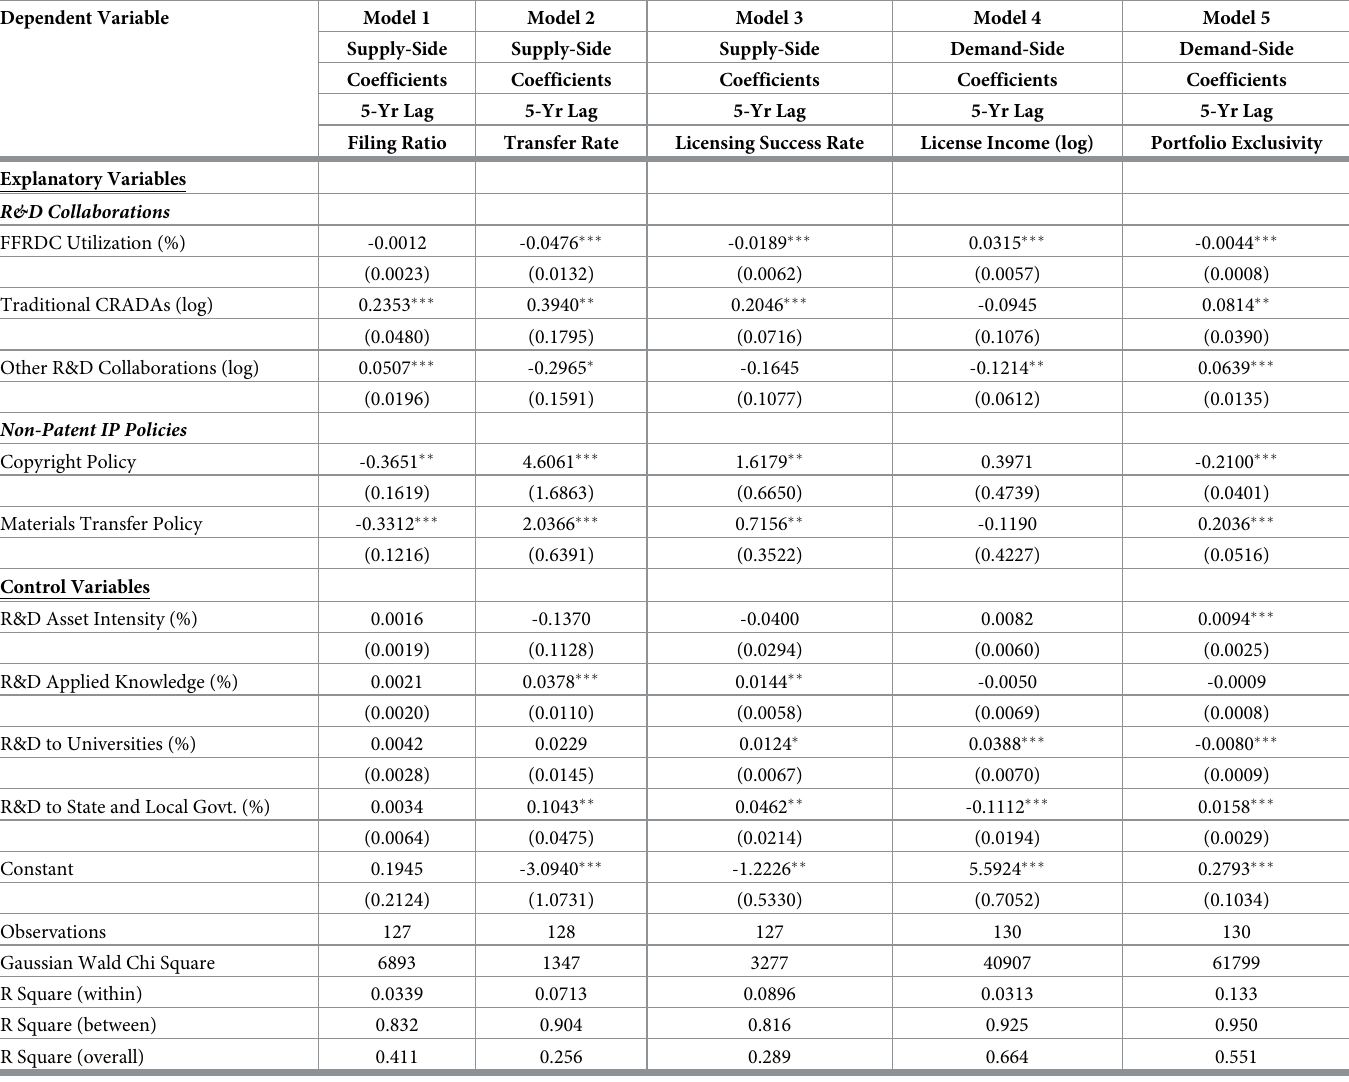
Table 4. The effects of R&D collaborations and non-patent IP policies on federal agency technology transfer performance